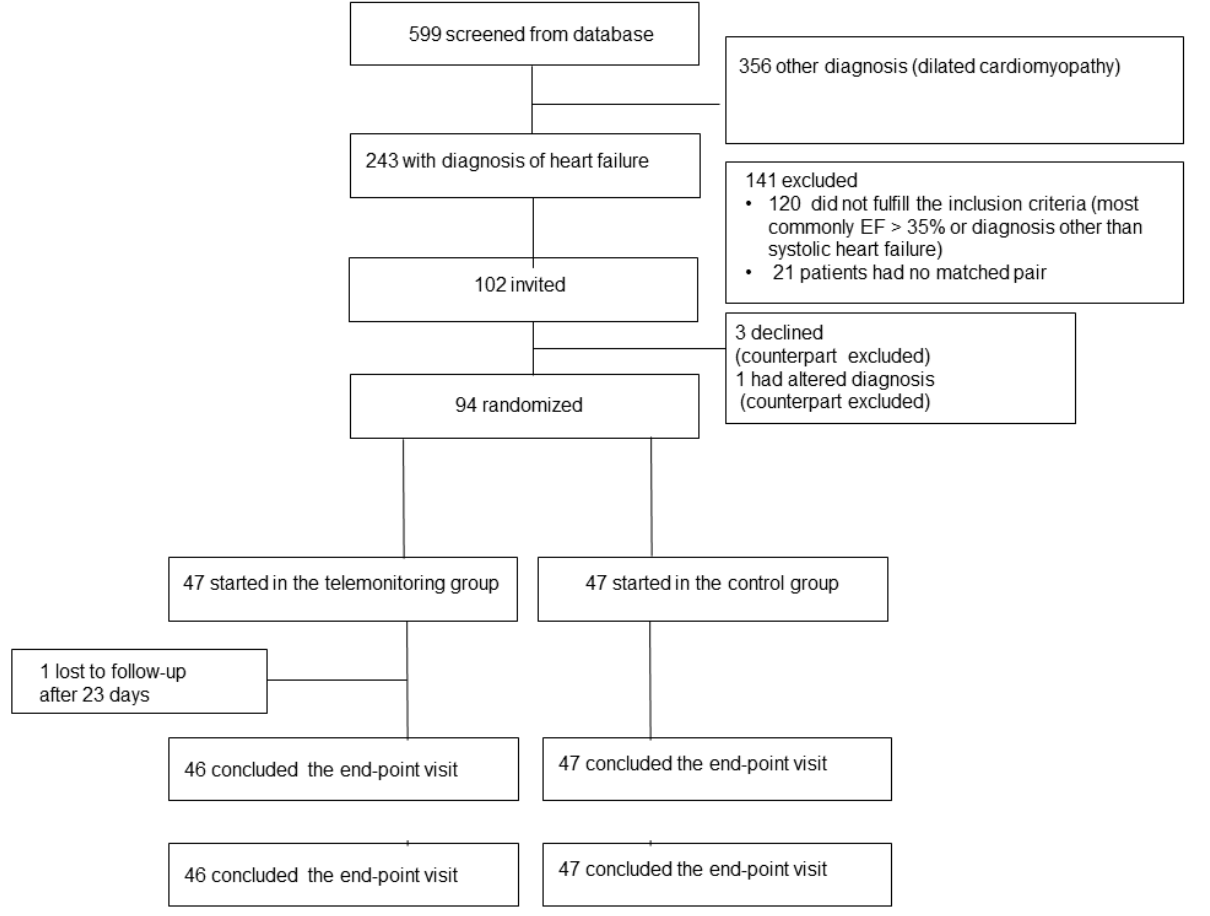
Figure 3. Screening, randomization, and follow-up of